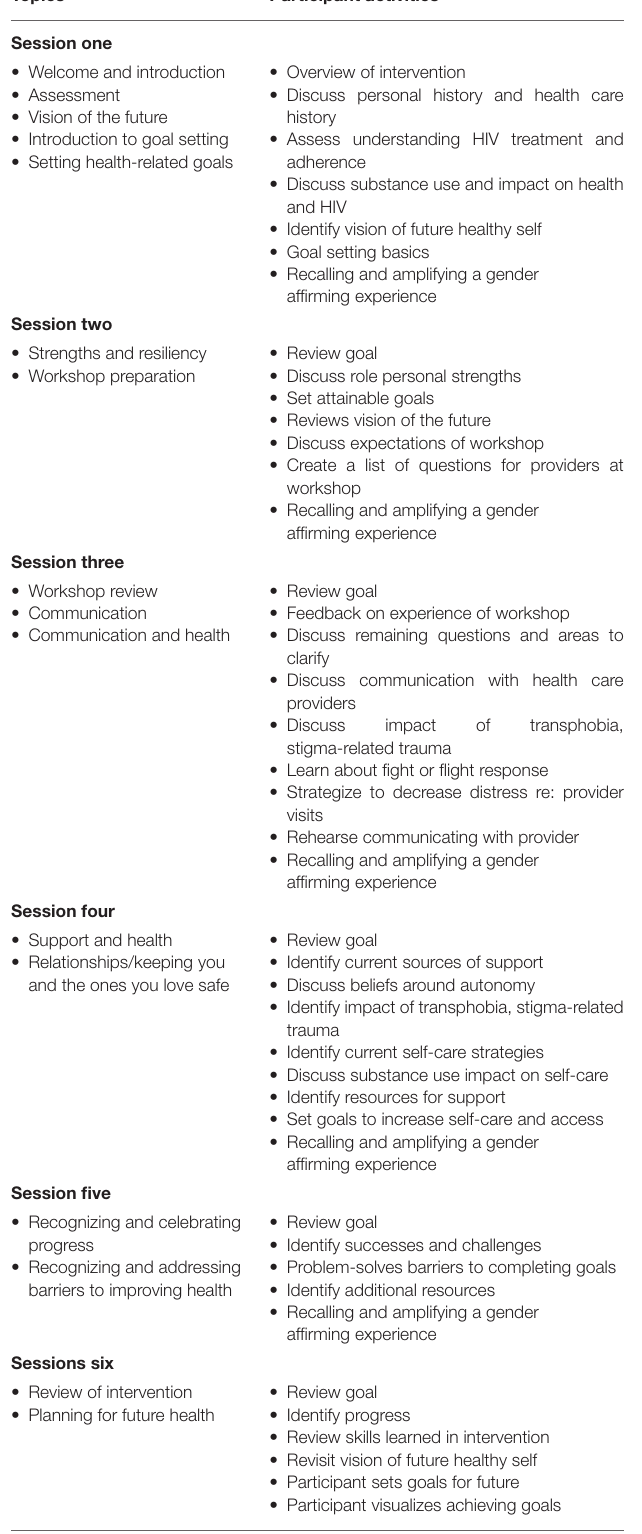
TABLE 1 | Healthy Divas intervention activities outline.